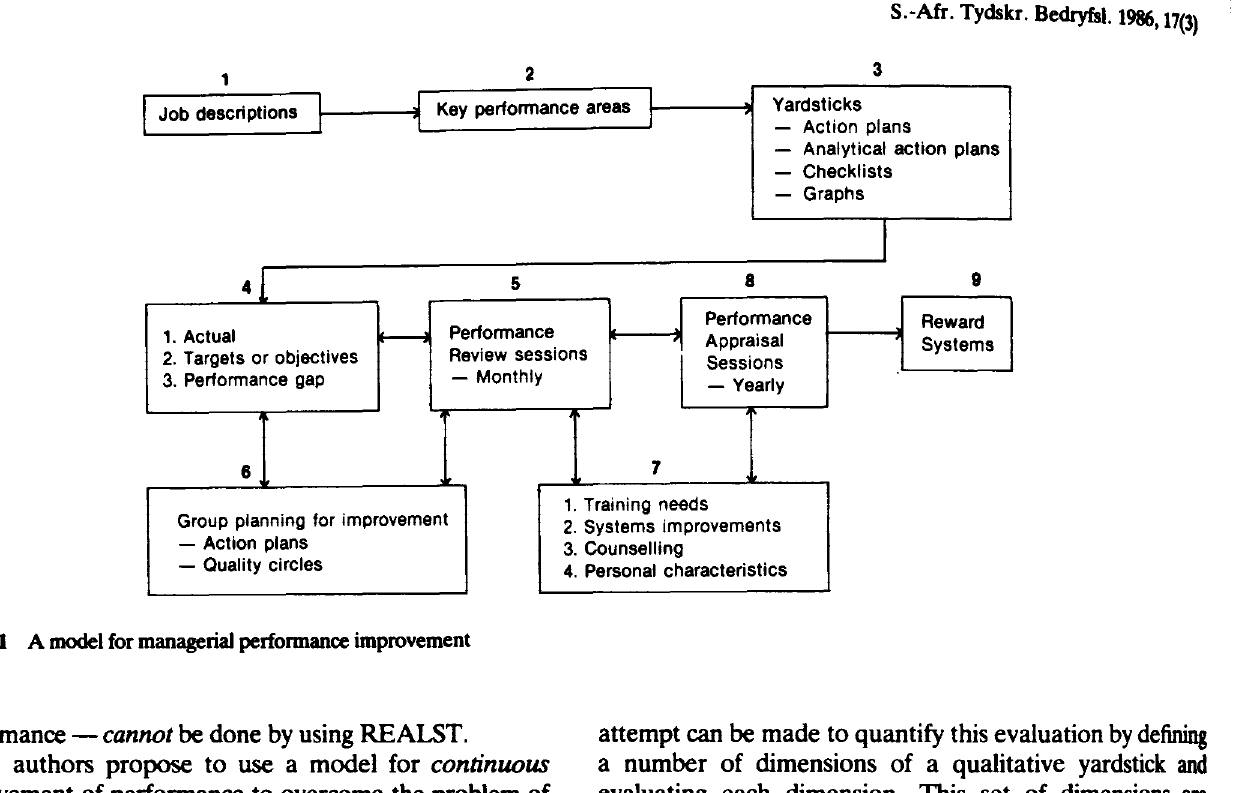
performance - cannot be done by using